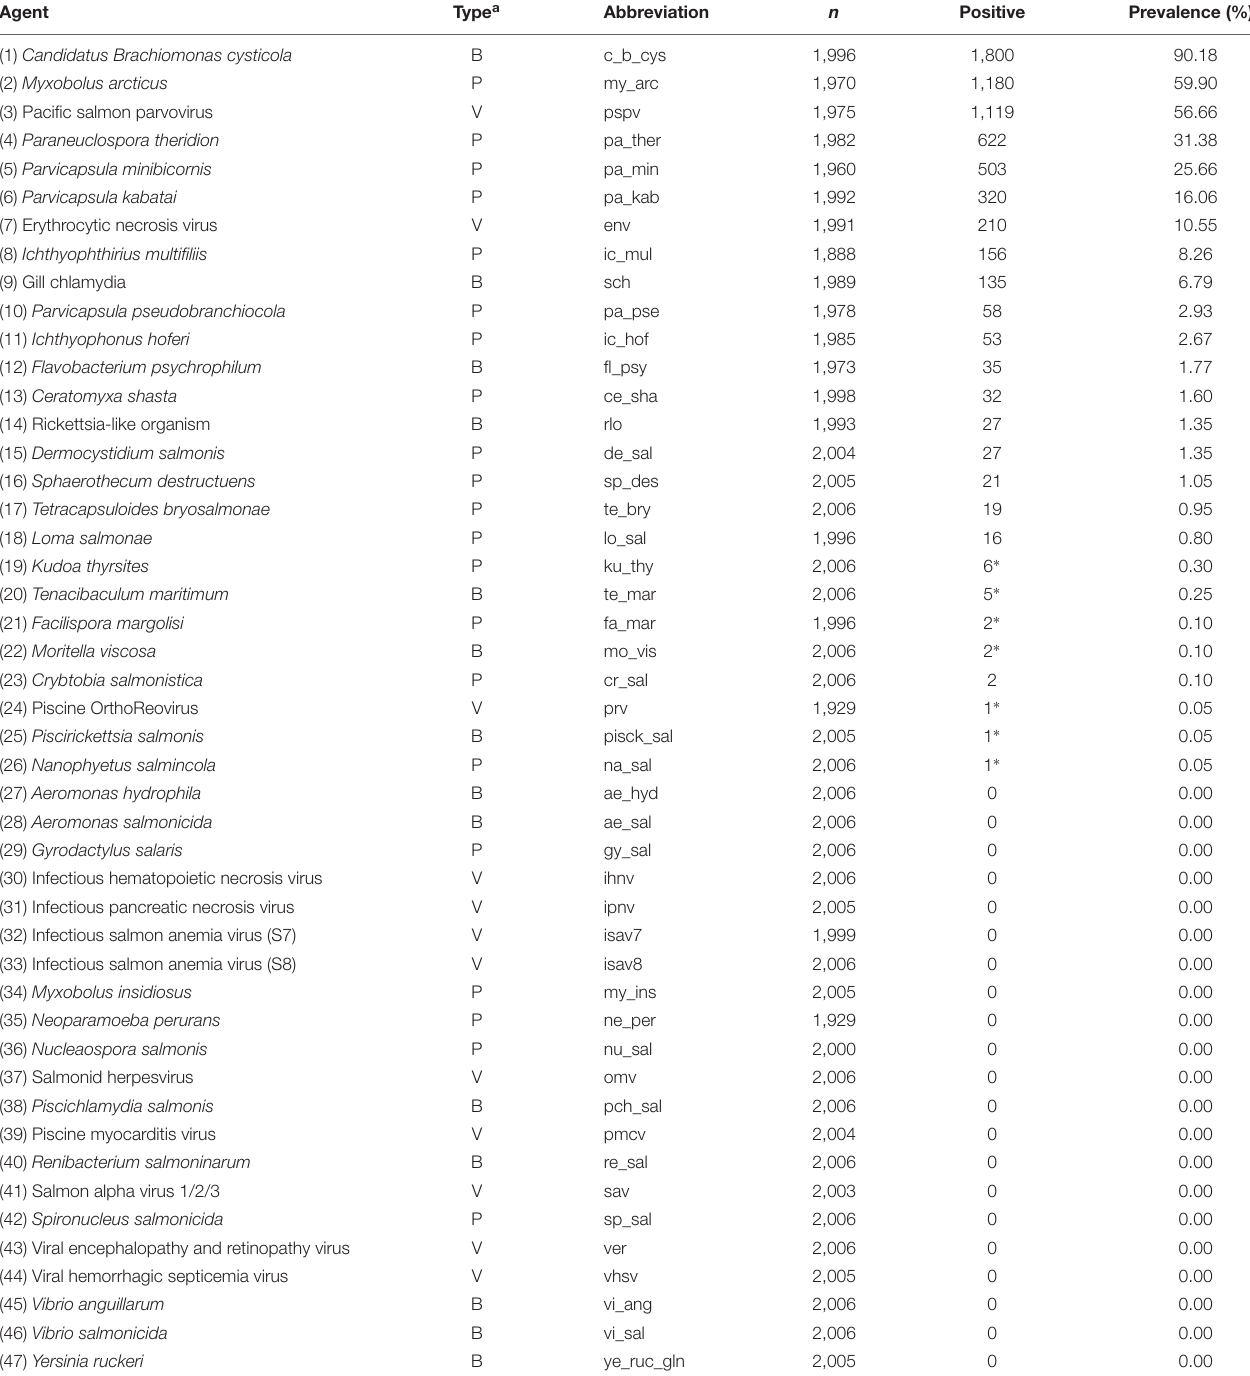
TABLE 1 | Forty-six infectious agents (including two strains for ‘isav’) tested on 2,006 out-migrating Fraser River Sockeye salmon in 2012 and 2013, along with their overall prevalences. Agent Type